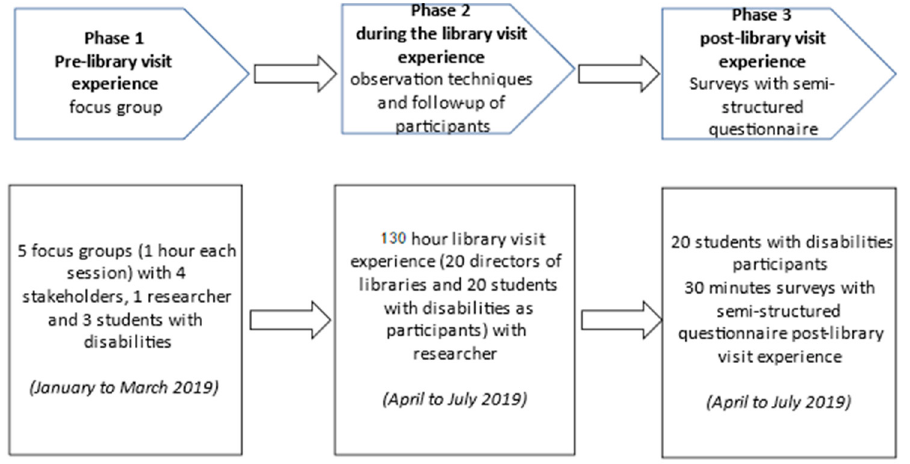
Figure 2. The project design breakdown and timeline.